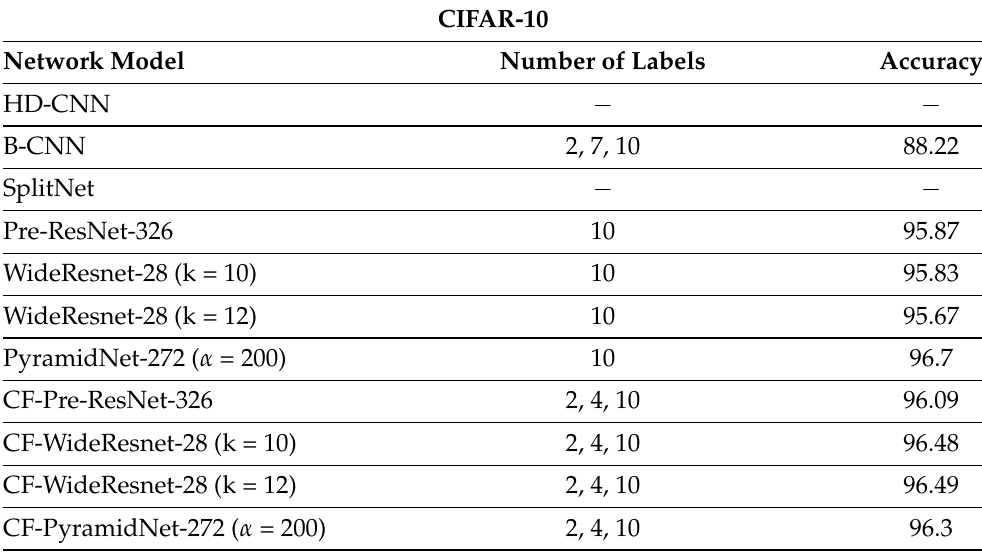
Table 10. Classification results with various classification models and grouping labels on the CIFAR- 10 dataset.